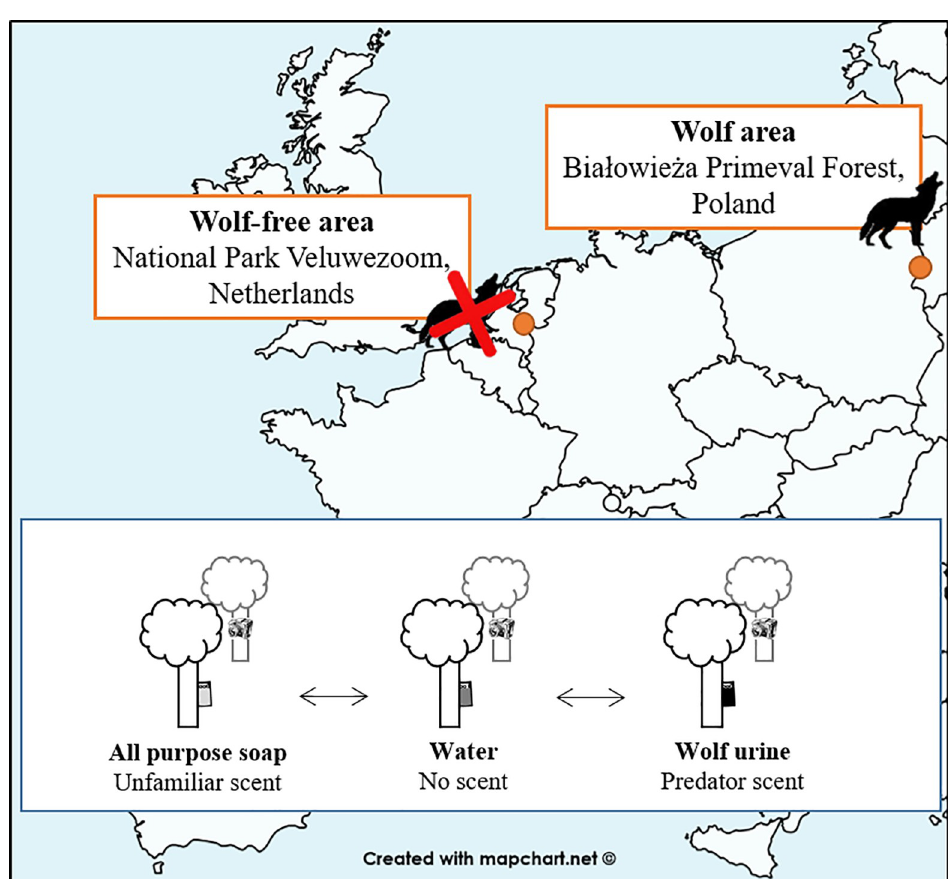
Fig 1. Design of our olfactory cue experiment in both case studies. In the wolf-absent National Park Veluwezoom (NPV), The Netherlands, deer live in absence of wolves for 150 years. In our wolf-present area the Białowie ż a Primeval forest (BPF), Poland, deer live along wolves for more than 100 years. In both study areas we established per location three scent plots at least 50 m apart to avoid one treatment influencing the other. The scent order was randomly decided. On each plot we placed a dispenser (small green plastic tube of 30 ml with two holes at the top) containing the scent and a camera trap at a tree directed towards the dispenser to monitor red deer behavior. We replicated this 25 times in the NPV and 20 times in the